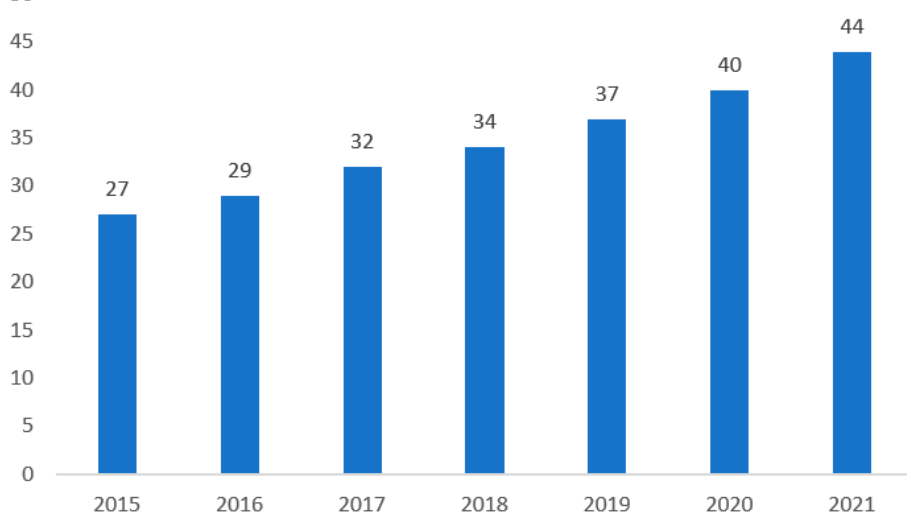
Figure 2. Estimated global human insulin market revenue from 2015 to 2021 (in USD billion). Source: Statista [15].